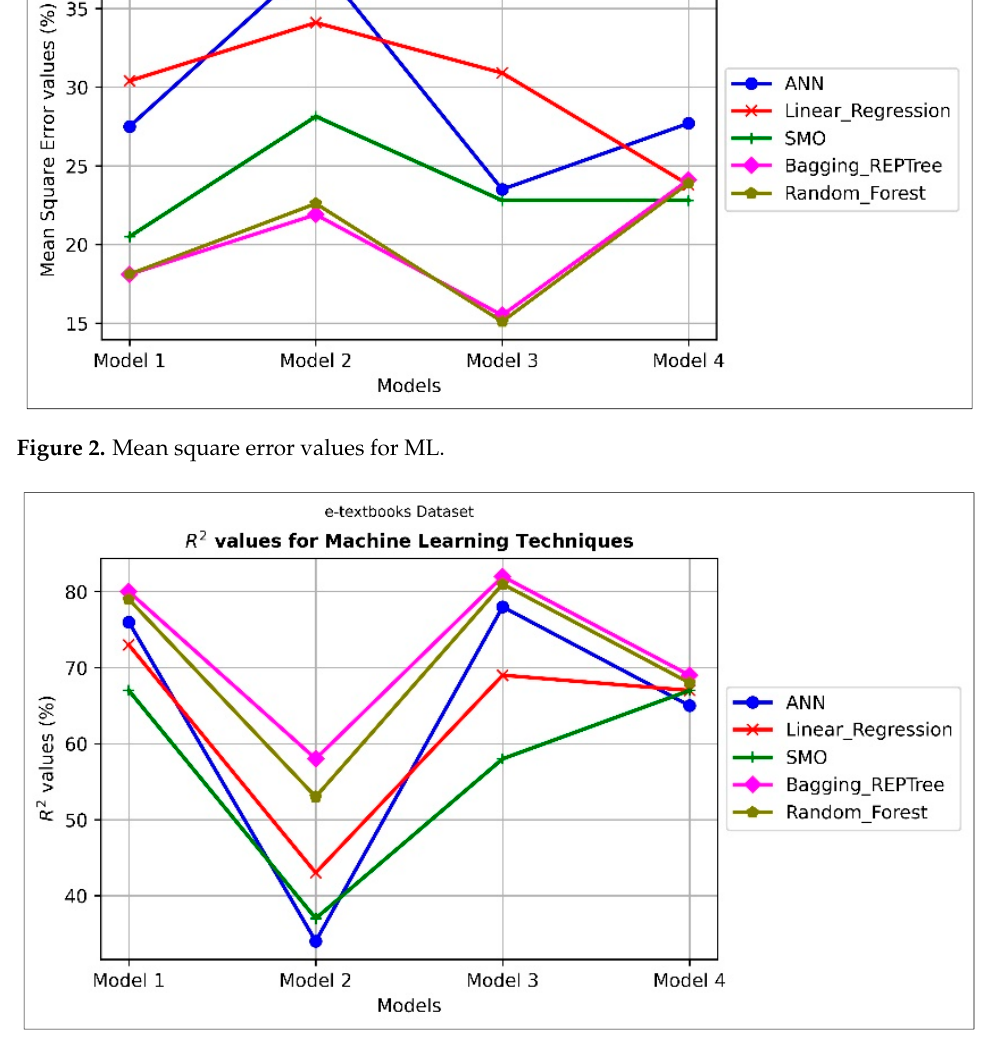
Figure 3. R 2 values for ML